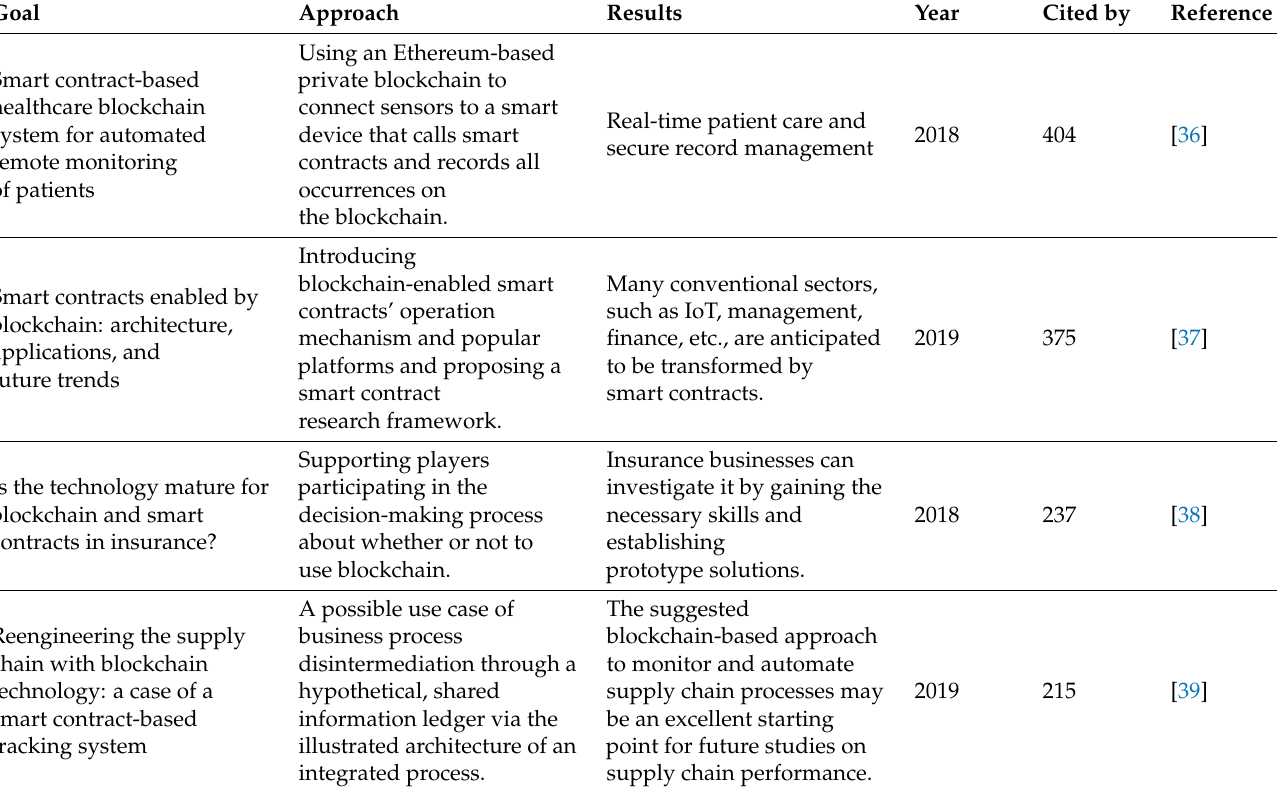
Table 2. Most cited articles between 2012 and